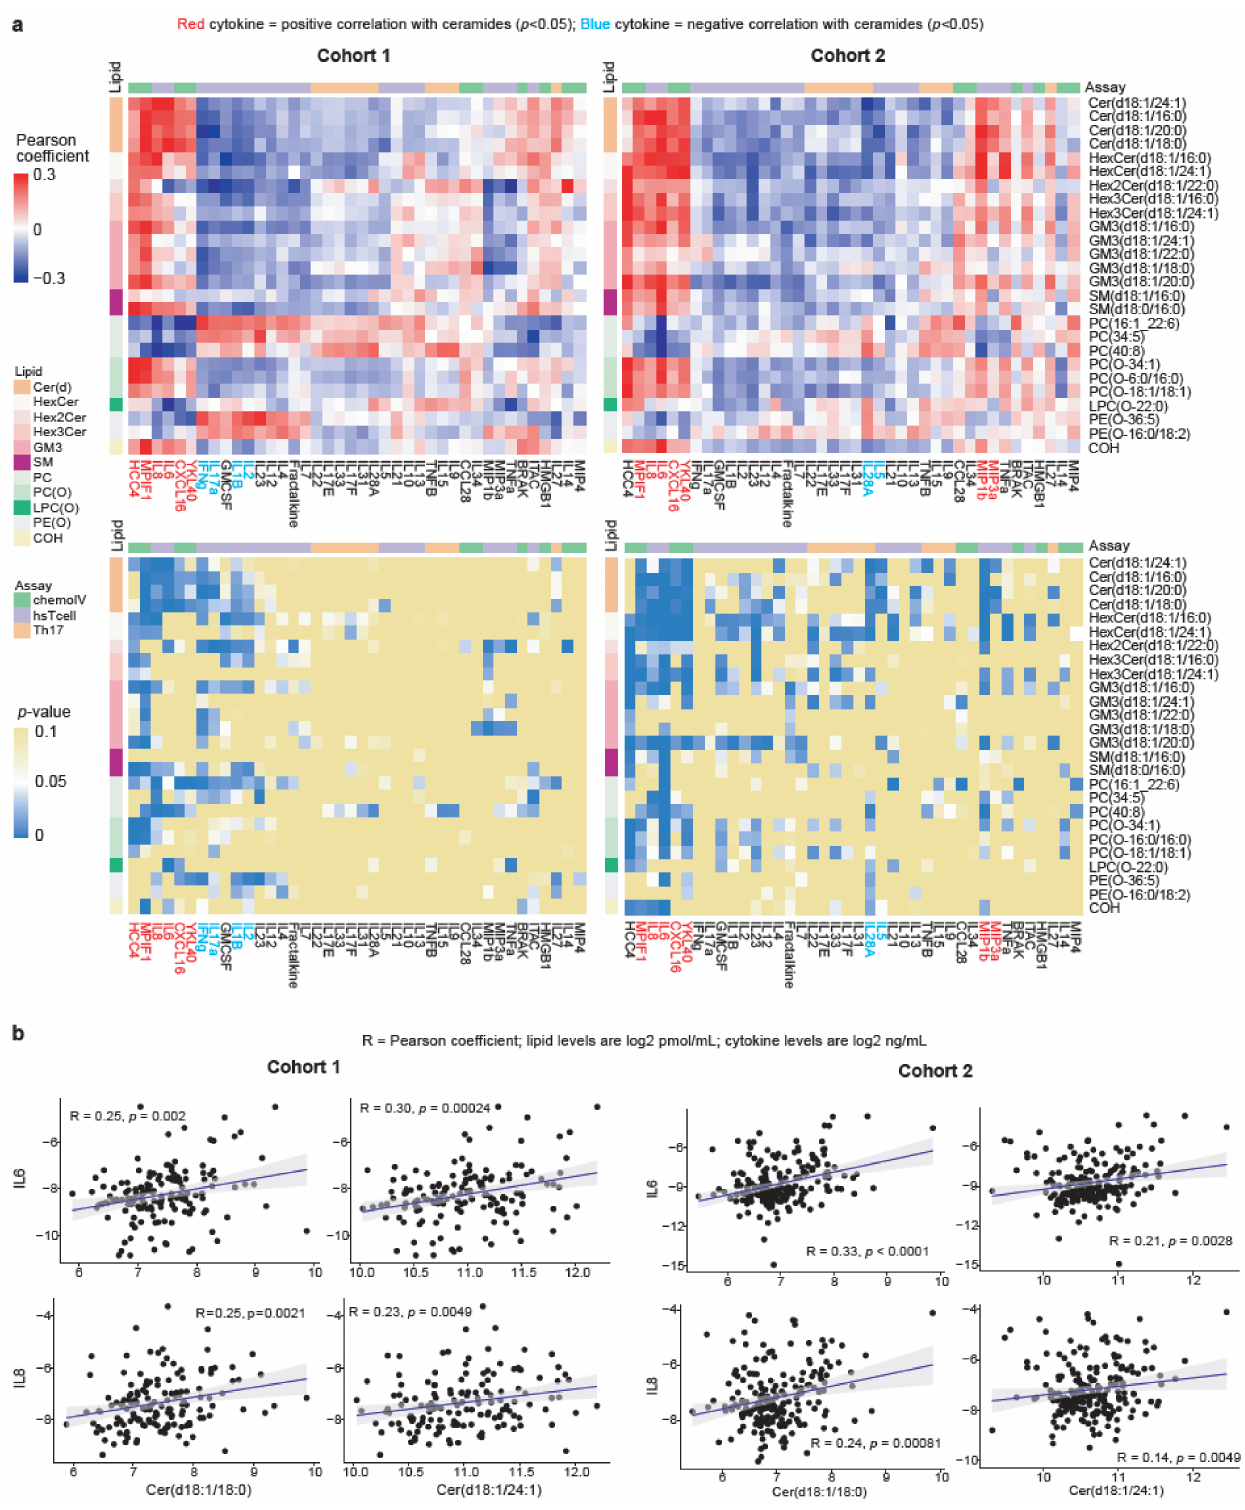
Figure 4. Correlation between circulating lipids and cytokines: ( a ) Heatmaps of Pearson coefficient and p -values of correla- tion between the plasma levels of cytokines and 26 prognostic lipids for Cohort 1 (left, 146 plasma samples) and Cohort 2 (right, 197 plasma samples). The cytokines are ordered by the hierarchical clustering of the Pearson coefficients of Cohort 1 (Euclidean distance); ( b ) Examples of scatterplots of the plasma levels IL6 or IL8 versus those of ceramide(d18:1/18:0) or